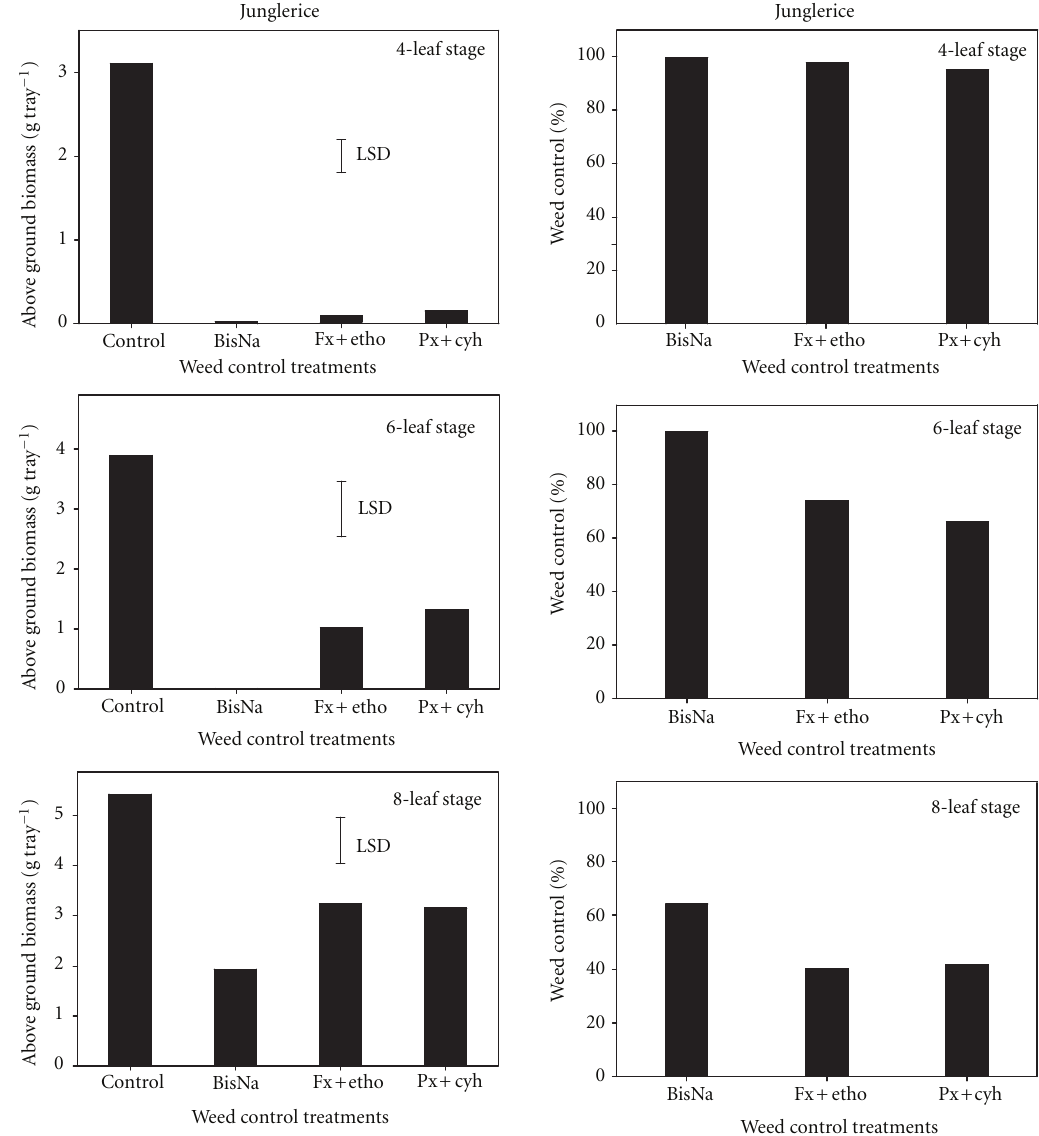
Figure 3: E ff ect of postemergence herbicides (BisNa, bispyribac-sodium; Fx + etho, fenoxaprop-p-ethyl + ethoxysulfuron; Px + cyh, penoxsulam + cyhalofop) on aboveground dry biomass (g) and control (%) of junglerice when sprayed at its four-, six-, and eight-leaf stages. Mean comparisons were performed based on least significant di ff erence test at